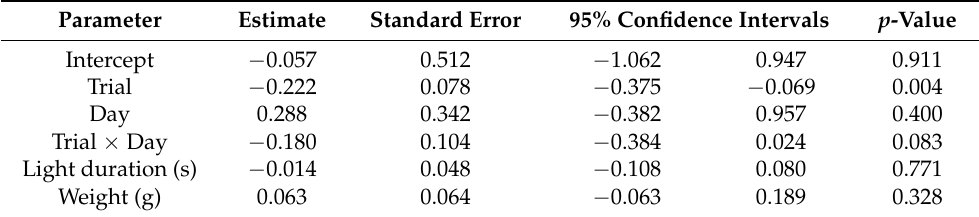
Table 2. Experiment 2 Startle Probability Regression